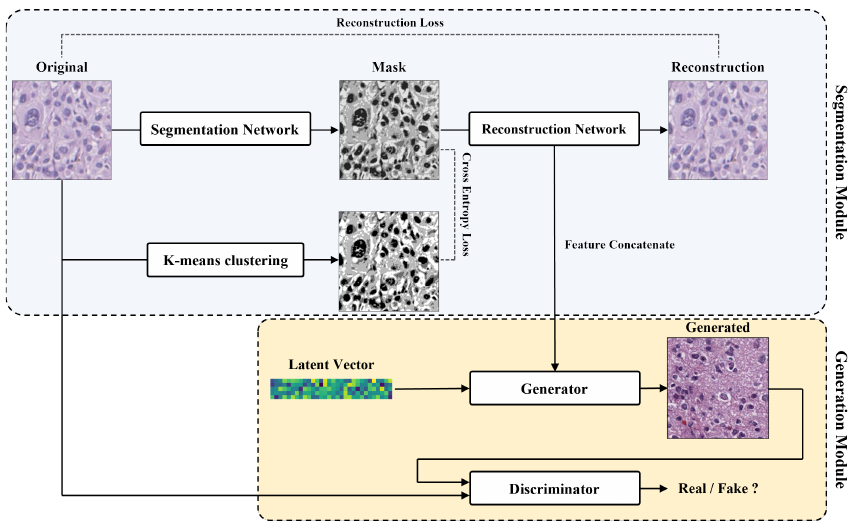
Figure 1. The overall flow of our proposed model. A segmentation module (light blue box), a generation module (yellow